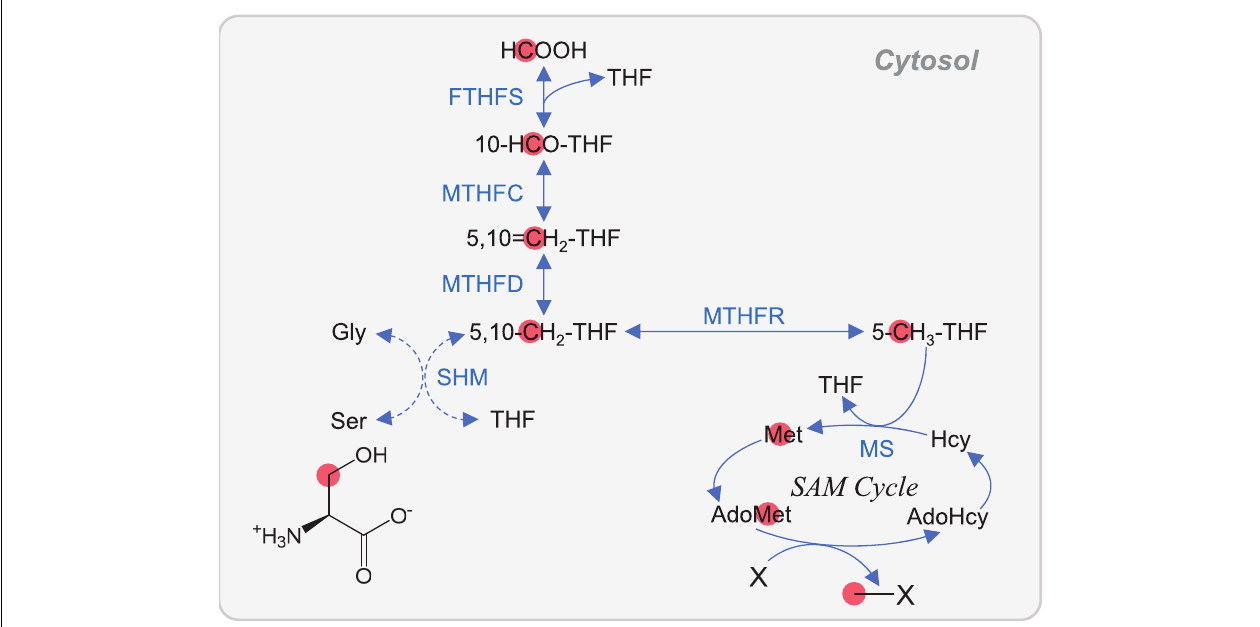
FIGURE 4 | C 1 metabolism in cytosol of plant. Carbon atoms of C 1 unit are shown as red circles. Abbreviations are listed in Table 1 . In Arabidopsis , the cytosolic bifunctional MTHFD/MTHFC is encoded by MTHFD1